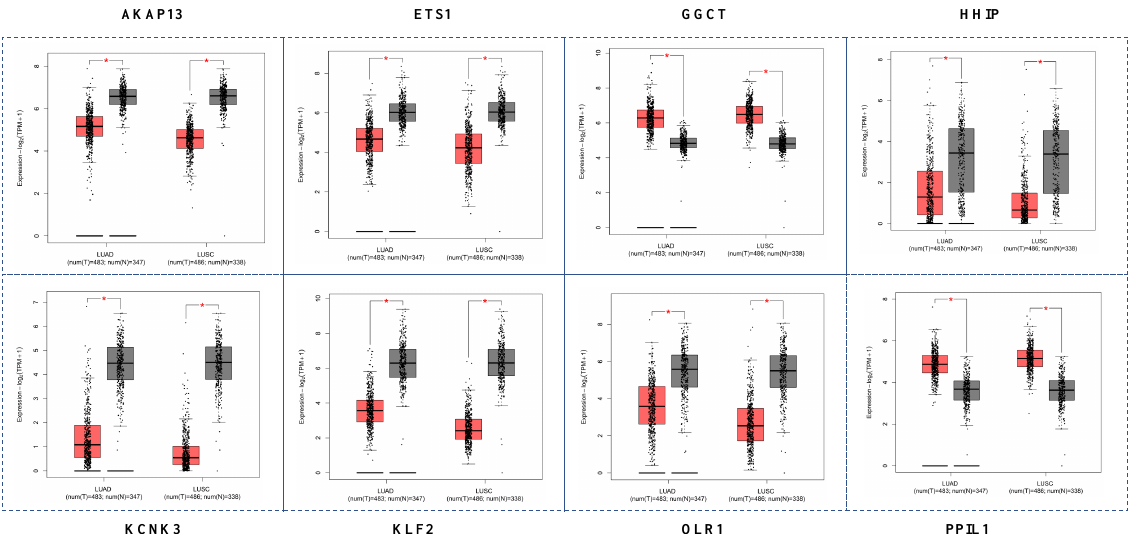
Figure 6. The validation of hub genes by the GEPIA. Here, we only show eight genes with a p -value ≤ 0.05. In this figure, NSCLC is divided into two types: lung adenocarcinoma (LUAD) and lung squamous cell carcinoma (LUSC). The symbol “*” indicated the significance level of the